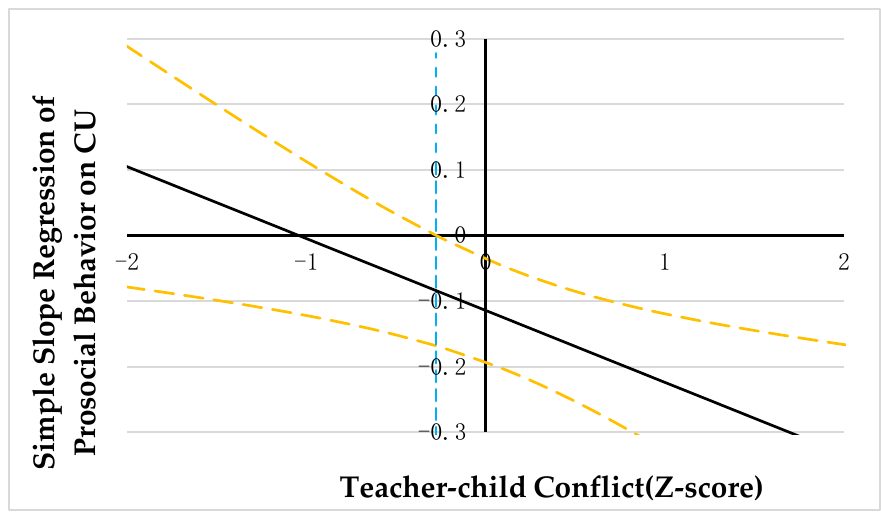
Figure 3. Johnson-Neyman regions of significance and confidence bands for mother-rated CU traits along teacher-child conflict in relation to prosocial behavior. Note. Solid diagonal line represents the regression coefficient for CU along with teacher-child conflict. Dashed diagonal yellow lines are confidence bands — upper and lower bounds of 95% confidence interval for CU coefficient along teacher-child conflict. The dashed vertical blue line indicates the point along teacher-child conflict at which the CU regression coefficient transitions from nonsignificance (left of dashed vertical line) to statistical significance (right of dashed vertical line). The value of the dashed vertical line is −0 .28.